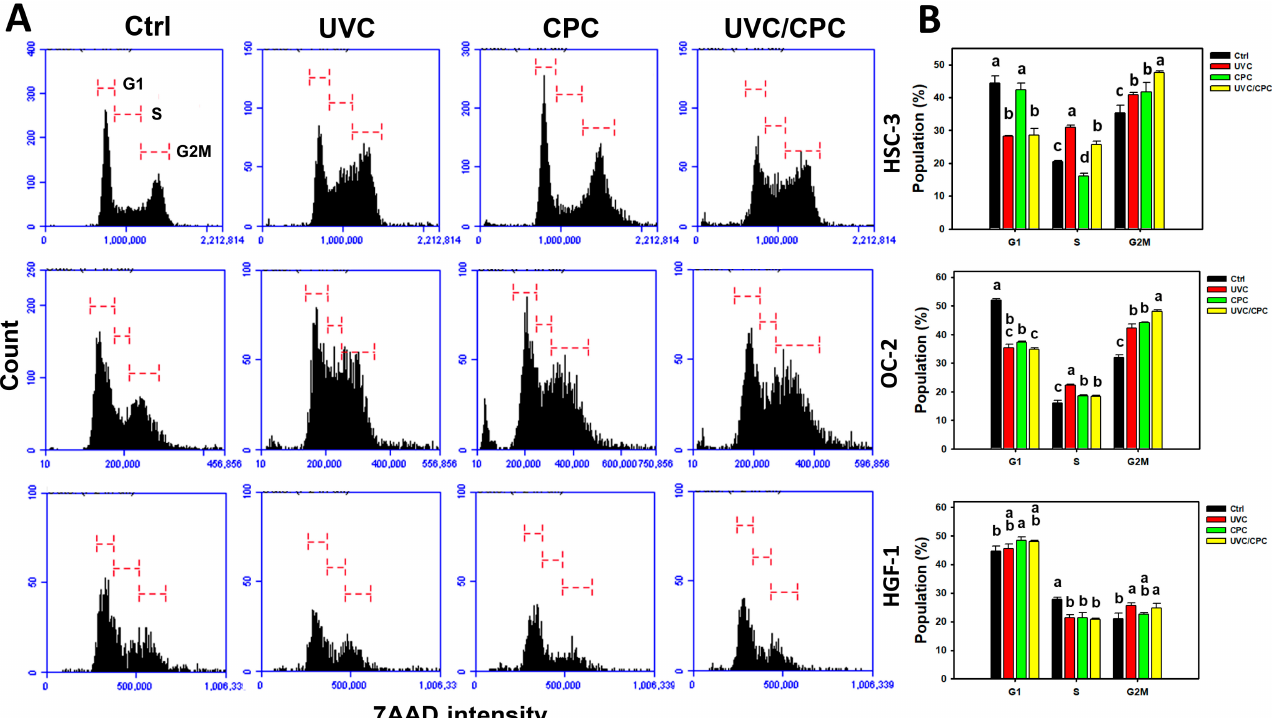
Figure 4. Cell cycle change of oral cancer and normal oral cells following UVC or/and CPC treatments. Oral cancer (HSC-3 and OC-2) cells were treated with vehicle control, UVC (10 J/m 2 ), CPC (5 µ g/mL), and UVC/CPC (10 J/m 2 and 5 µ g/mL). The cell cycle was determined by flow cytometry after 24 h treatment. ( A ) Cell cycle patterns. ( B ) Statistics for ( A ). Data, mean ± SD ( n = 3). Based on multiple comparisons after Tukey’s HSD Tests, different top letters indicated significant differences for the same cell cycle phase of the same cell lines ( p <